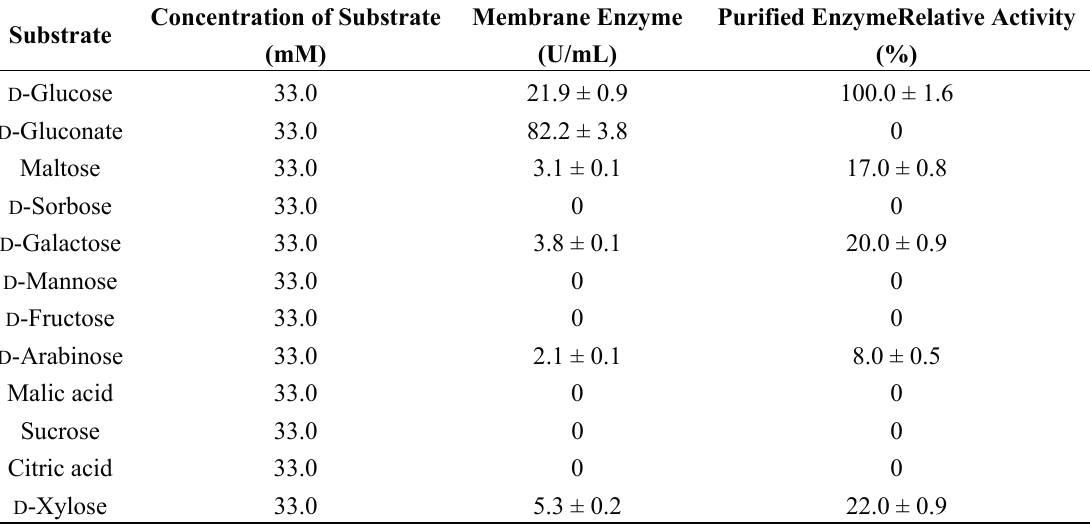
Table 3. Substrate specificity of GlcDH from A. globiformis